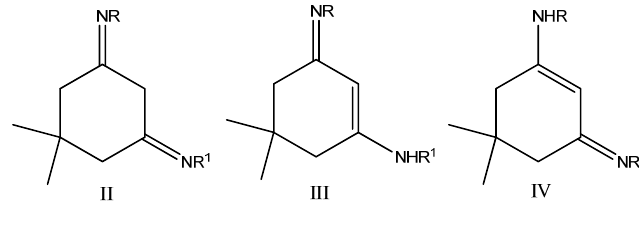
Figure 1 . The possible tautomers of the diimines derived from